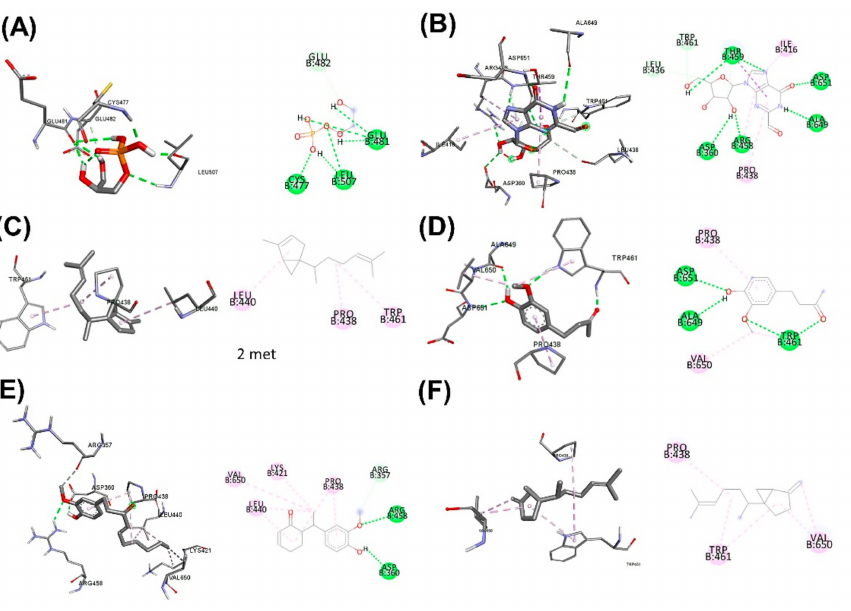
Figure 6. 3D (LHS) and 2D (RHS) Molecular docking pose visualization showing water extraction of Z. officinale : ( A ) Alirocumab, ( B ) 2-Formyl-9-[.beta.-d-ribofuranosyl]hypoxanthine, ( C ) (1S,5S)- 2-Methyl-5-((R)-6-methylhept-5-en-2-yl)bicyclo[3.1.0]hex-2-ene, ( D ) 2-Butanone, 4-(4-hydroxy-3- methoxyphenyl)-, ( E ) 1-(4-Hydroxy-3-methoxyphenyl)dec-4-en-3-one, ( F ) (1S,5S)-4-Methylene-1- ((R)-6-methylhept-5-en-2-yl)bicyclo[3.1.0]hexane interactions with